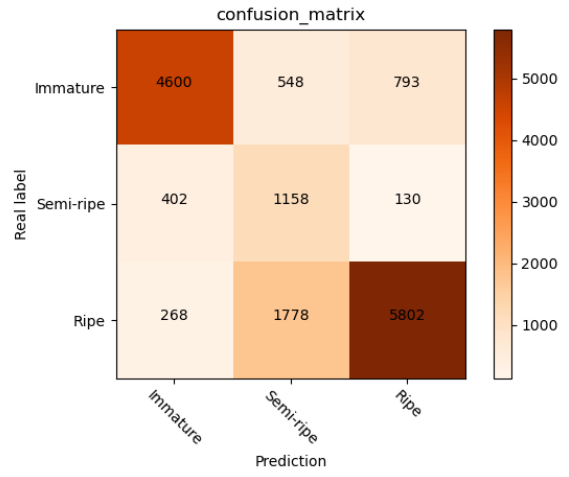
Figure 6. Confusion matrix of YOLOX-EIoU-CBAM network.